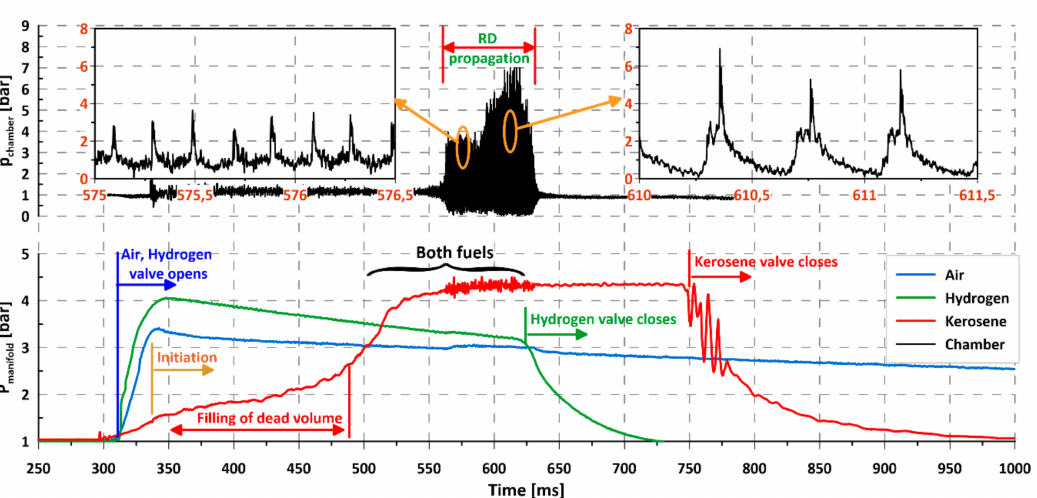
Figure 4. Initiation and propagation of rotating detonation for kerosene–air mixture and with gaseous addition of hydrogen (course of